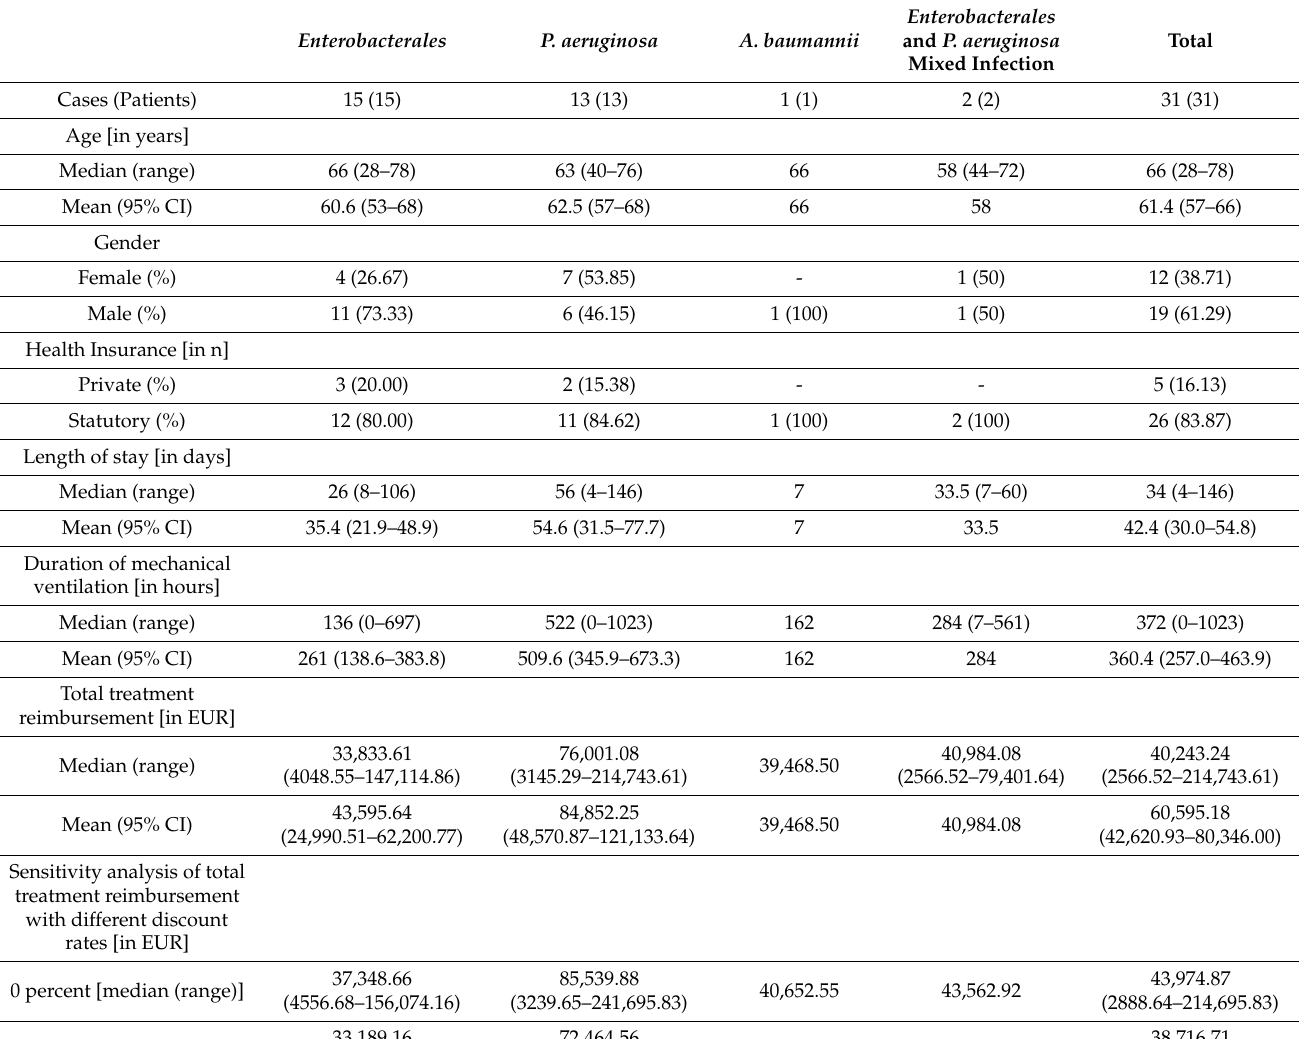
Table 1. Baseline patient characteristics and hospital reimbursement-relevant treatment